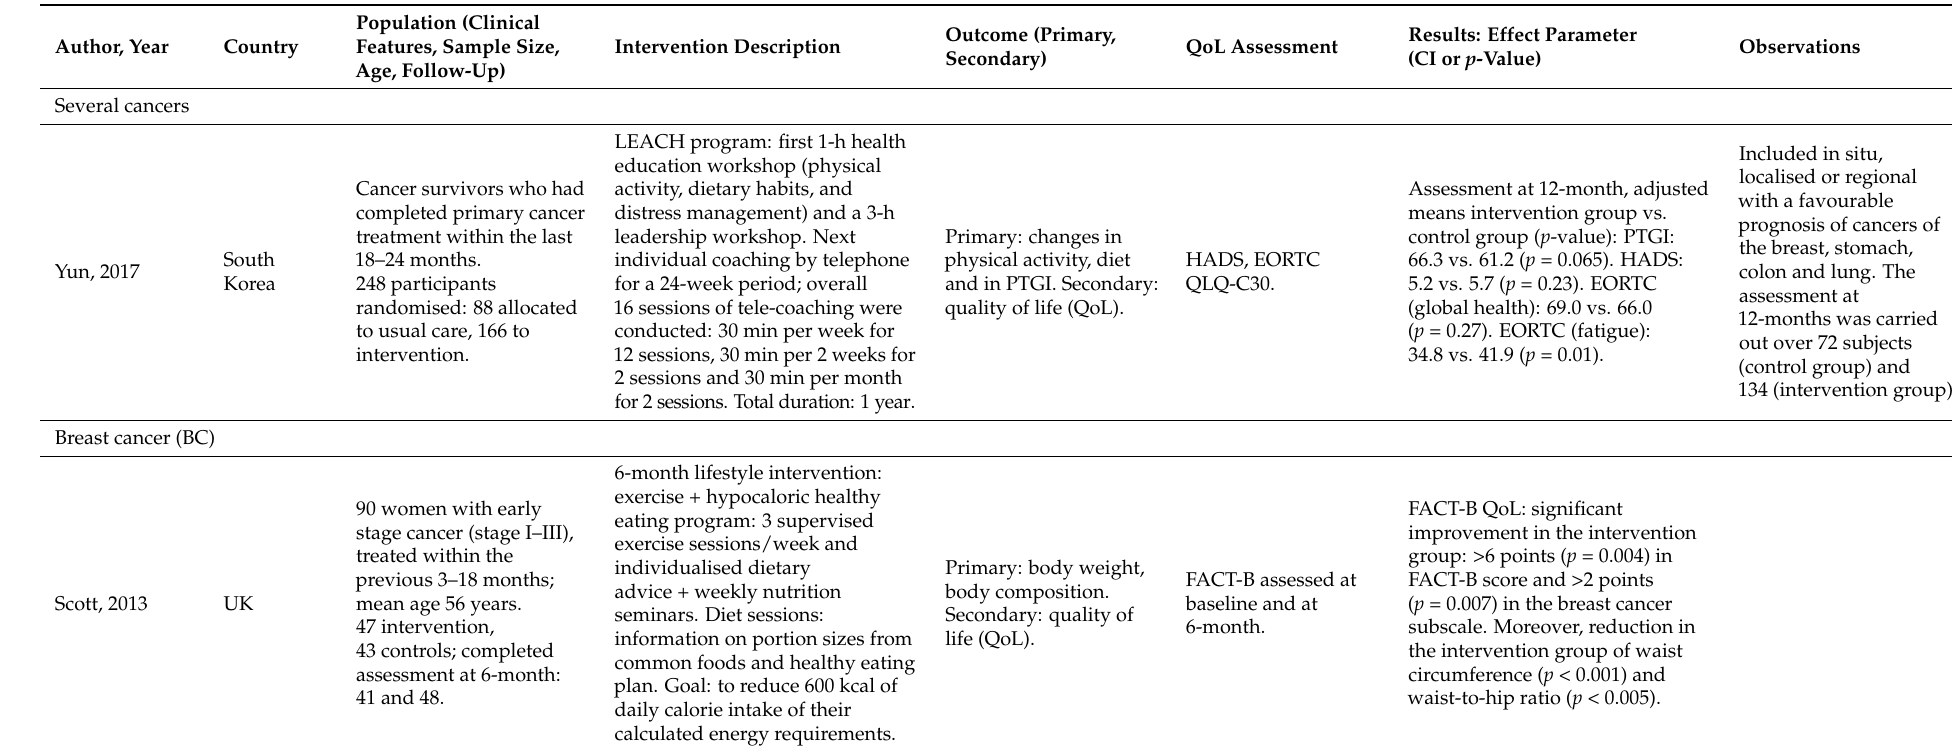
Table 2. Characteristics of the included randomised controlled trials ( n = 14) examining the association between dietary interventions and prognosis in cancer